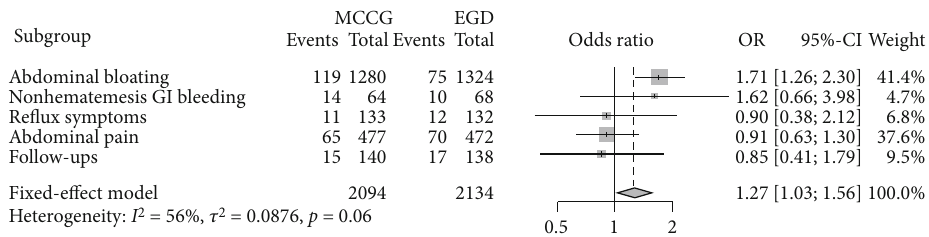
Figure 5: Forest plot of the comparison of di ff erent chief complaints and gastric ulcer detection rates between the MCCG and C-EGD groups. ∗ OR: odds